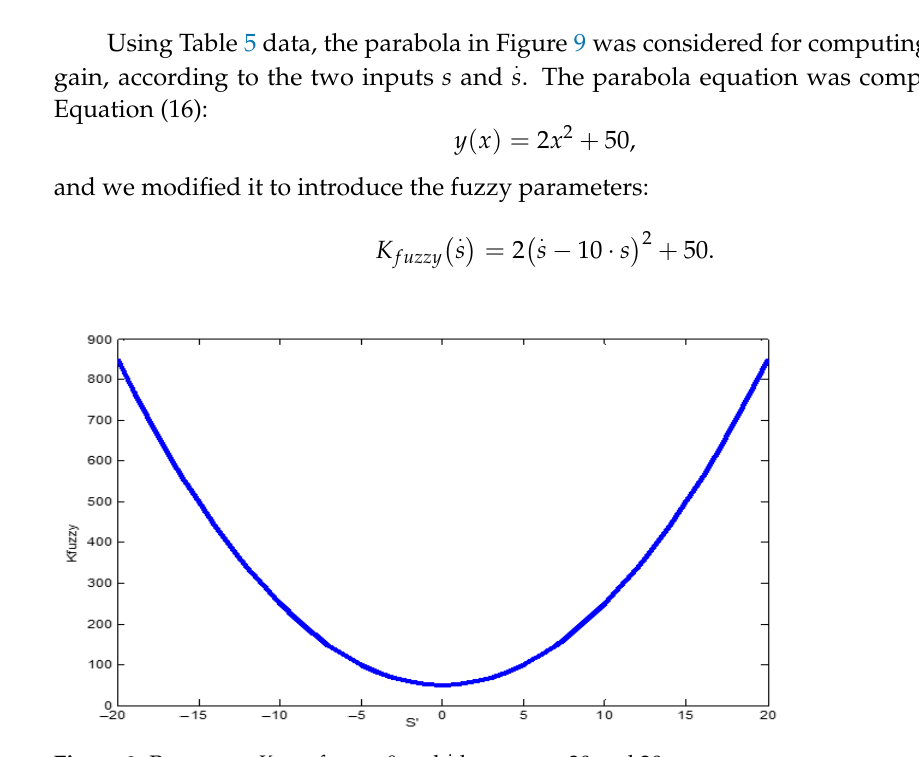
. s between − 20 and